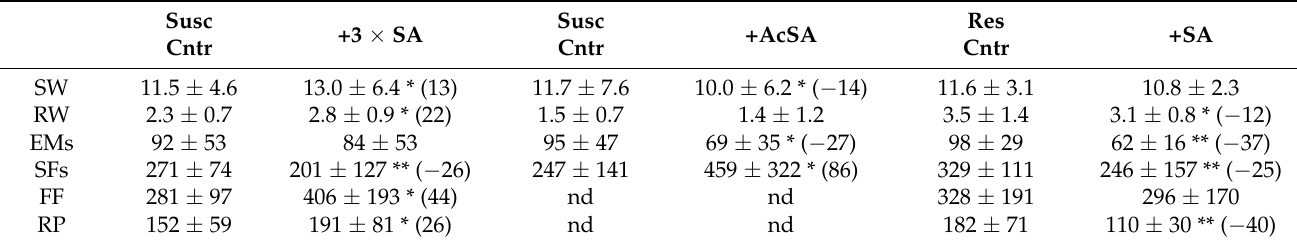
Table 3. Plant growth and infection factors detected 40 days after inoculation with RKN J2s (250 J2/plant), in untreated (cntr) and chemical-treated tomato. SA (5.0–10.0 mg g − 1 plant fresh weight at treatment) was applied thrice to susceptible plants by soil drench: 1 day before inoculation and 7 and 14 days after inoculation. One pre-treatment of acetyl-salicylic acid (AcSA, 5.0–7.0 mg g − 1 plant fresh weight at treatment) was also applied to susceptible plants. Resistant (res) plants were treated with 2.5–6.0 mg SA g − 1 pfw and inoculated with a virulent population. Plant growth was assessed by shoot (SW) and root weights (RW) expressed in grams; nematode infection severity is indi- cated by numbers of egg masses (EMs) per root system, sedentary forms (SFs) per root system, female fecundity (FF), and reproduction potential (RP). Mean values ± standard deviations obtained from untreated and AC-treated tomato plants were differentiated by a paired t -test (* p < 0.05; ** p < 0.01). In parentheses, significant differences are expressed in percentages.